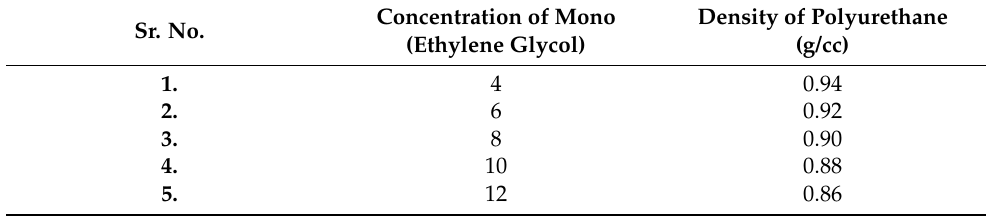
Table 7. Density of the polyurethane at different concentrations of monoethylene glycol. Concentration of Mono Density of Polyurethane Sr. No. (Ethylene Glycol)